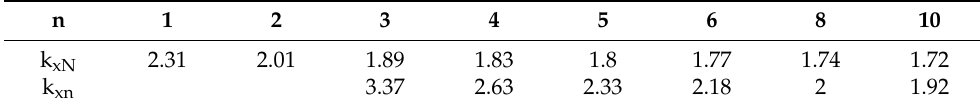
Table 2. Factor k x as a function of the number of tested